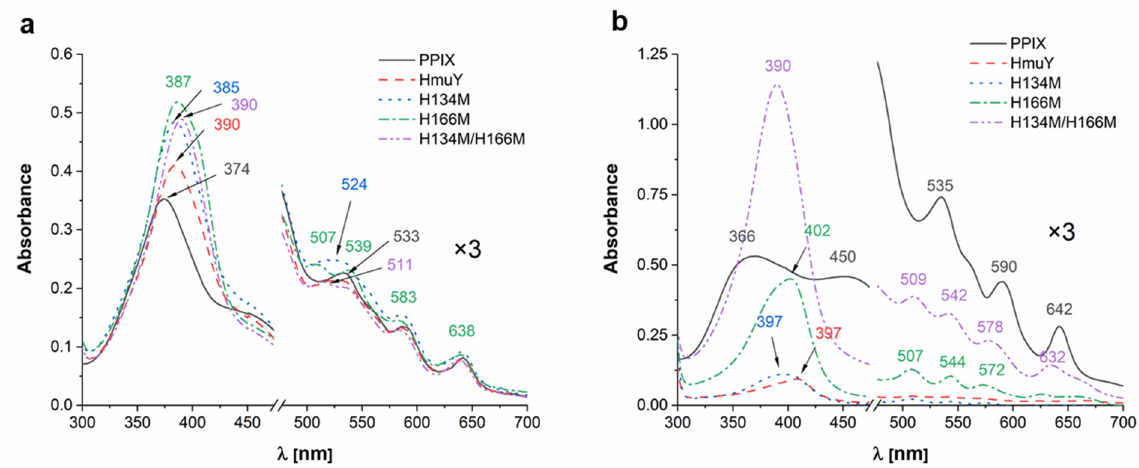
Figure 6. Analysis of PPIX binding to site-directed mutagenesis HmuY variants. UV-visible absorp- tion spectra of proteins in complex with PPIX (1:1 protein:PPIX ratio) were recorded ( a ). Proteins were also incubated with PPIX (1:1.2 protein:PPIX ratio), unbound PPIX was removed by gel filtration, and UV-visible absorption spectra were recorded ( b ). Absorbance spectra at the Q band region are magnified three times (×3).